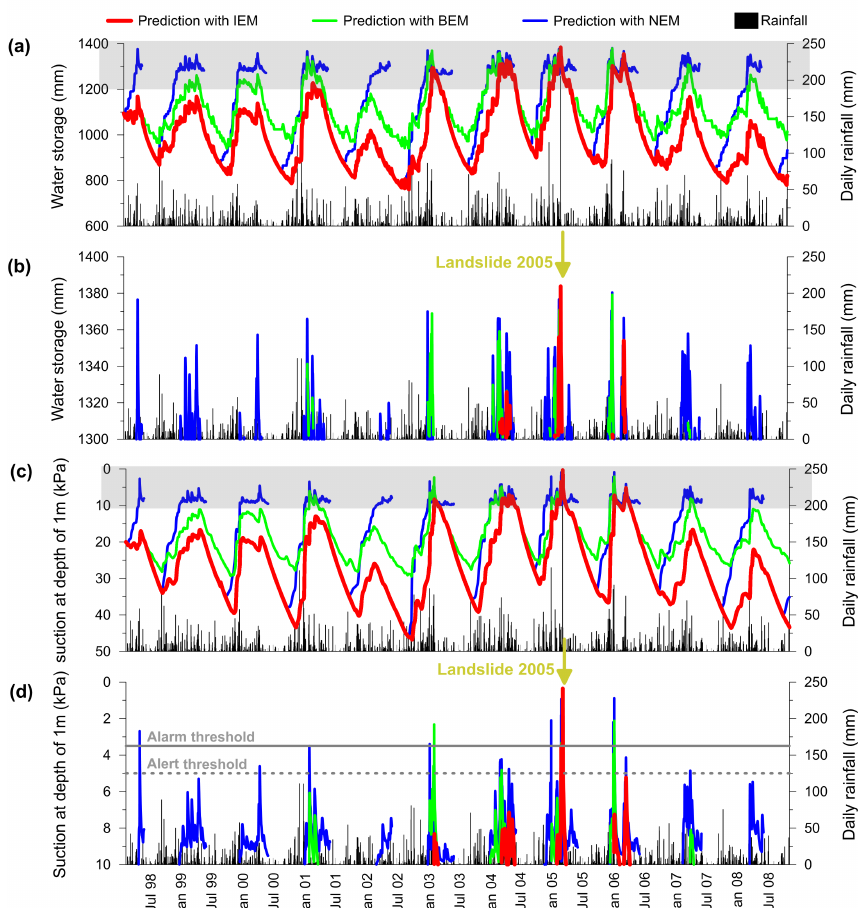
Figure 15. NEM, BEM and IEM predictions of the hydrological behaviour evolution for the layer involved in the 2005NIL: (a) prediction within the WS full range; (b) prediction for WS levels higher than 1300mm; (c) prediction within the suction full range; (d) prediction for suction levels lower than